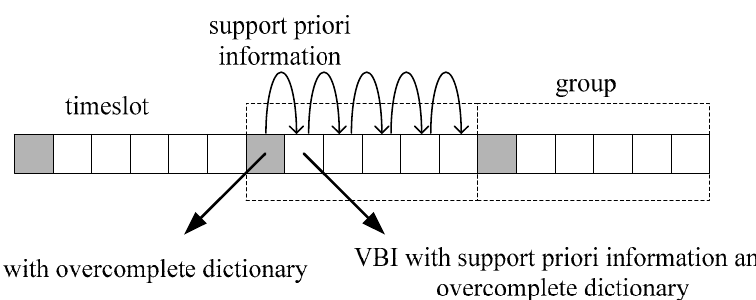
Figure 2. Channel estimations by group. Each block represents one timeslot, and the block filled with grey is the timeslot with variational Bayesian inference (VBI) for the channel estimation, while the blank blocks are the timeslots with the proposed algorithm for channel estimation.